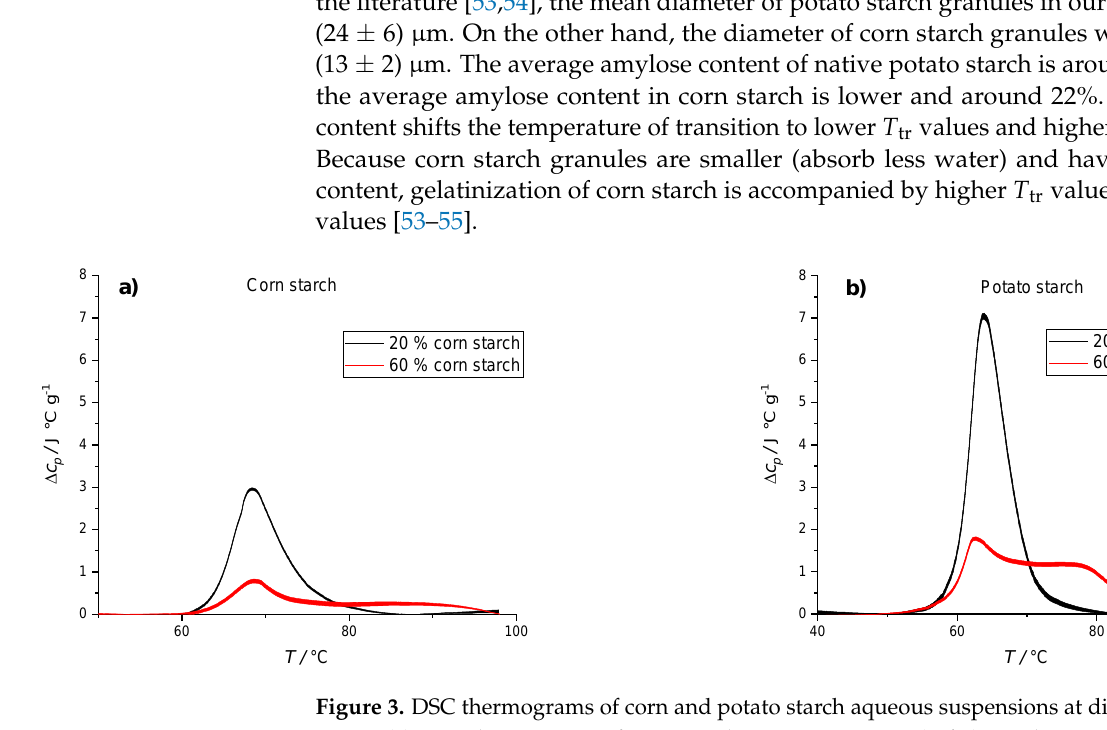
Figure 3. DSC thermograms of corn and potato starch aqueous suspensions at different starch:water ratios. ( a ) DSC thermogram of corn starch suspension; 20% ( w / w ) starch in water (black line) and 60% ( w / w ) suspension of starch in water (red line). ( b ) DSC thermogram of potato starch suspension; 20% of starch in water (black line) and 60% of starch in water (red line). The lines represent averages of three independent experiments ( n = 3) and the line thickness corresponds to SD.